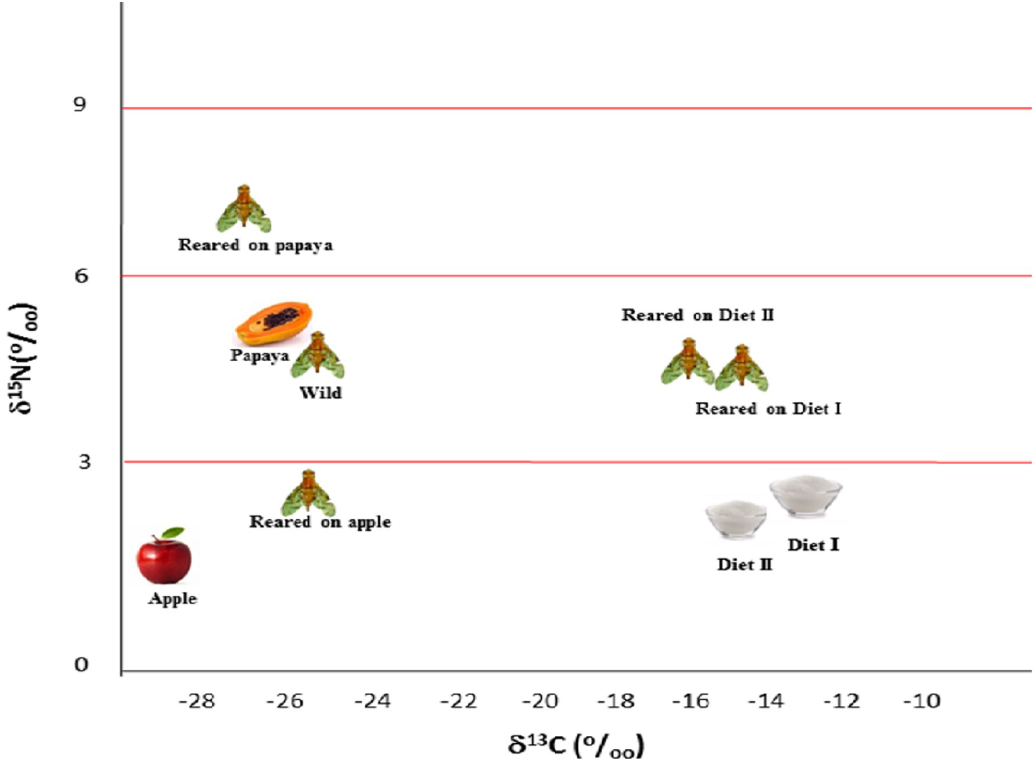
Fig 1. Distribution of the mean values of δ 13 C and δ 15 N of larval diets, fruits, and Anastrepha fraterculus flies reared in laboratory and wild flies (original means ± standard errors in Table 4).